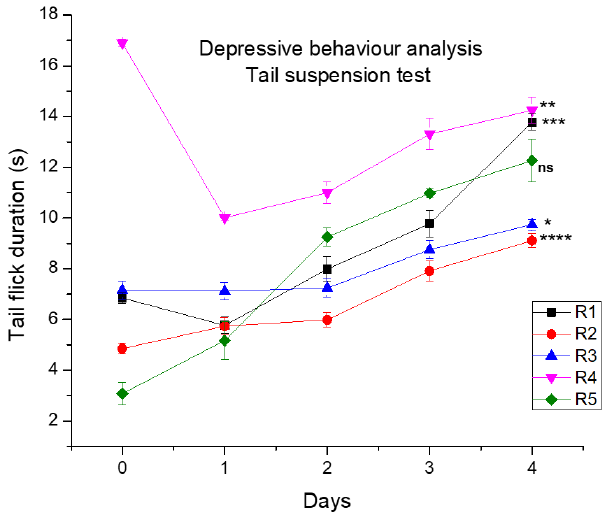
Figure 11. Tail flick test for the analysis of depression behavior gels. Where, *, **, ***, **** and ns represent, less significant, more significant, very much significant and non significant.